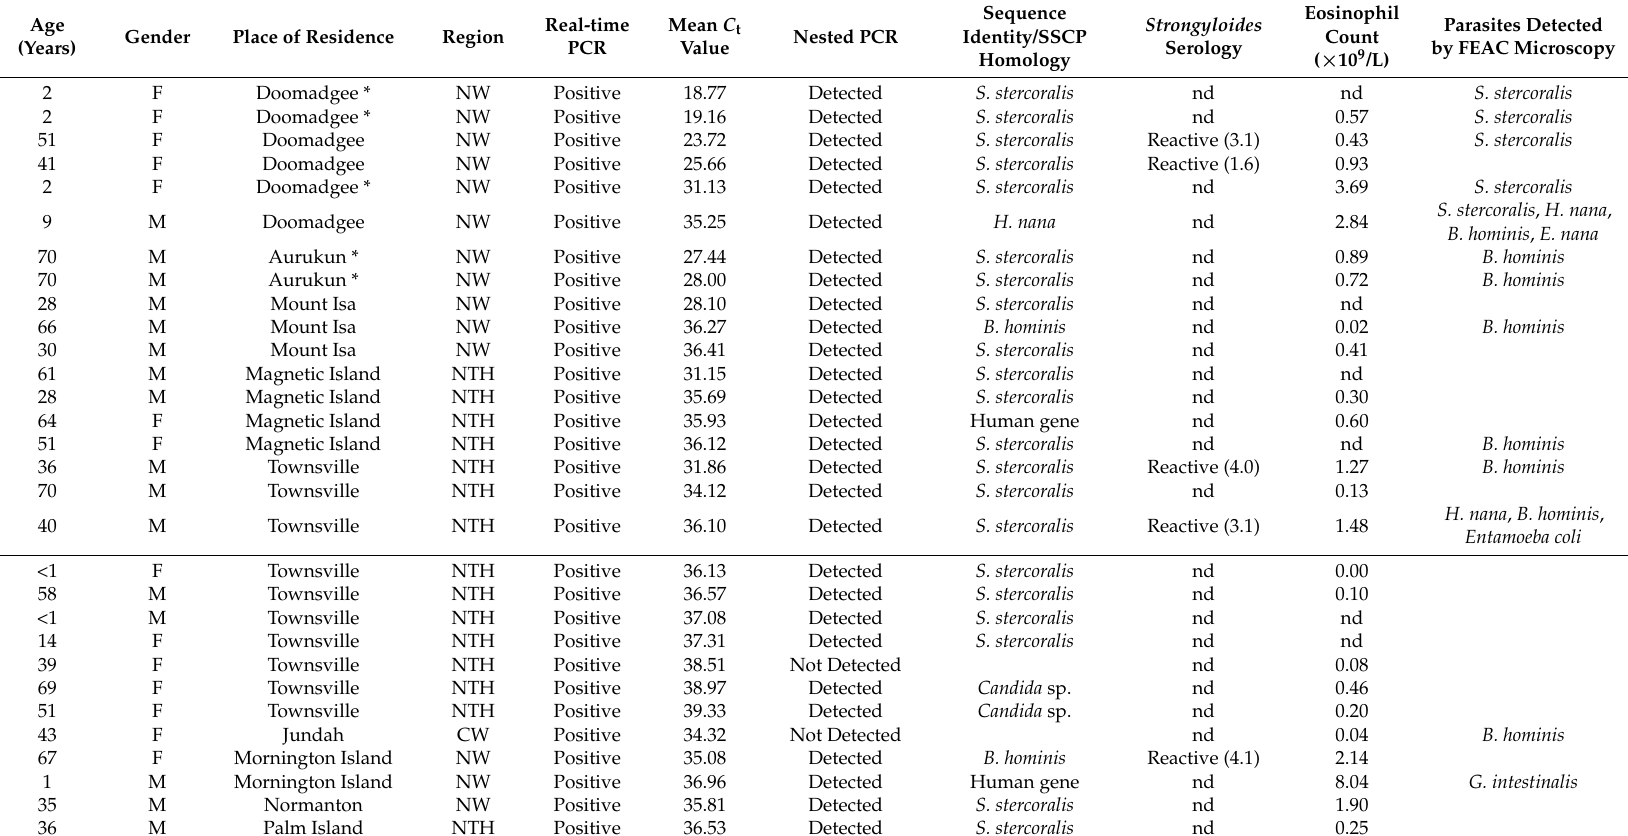
Table 1. Characteristics of patients with faecal samples submitted for diagnostic testing that yielded positive, equivocal or low level amplification Strongyloides sp. 18S rRNA real-time PCR compared to confirmatory testing using a second nested Strongyloides sp. 18S rRNA PCR with SSCP and sequencing. Values in bold are positive/above the normal range; * same patient; ˆ another specimen on the same patient was PCR negative; Eos: eosinophil; nd; not done; SSCP: single strand conformation polymorphism; NW: North West; NTH: North; CW: Central